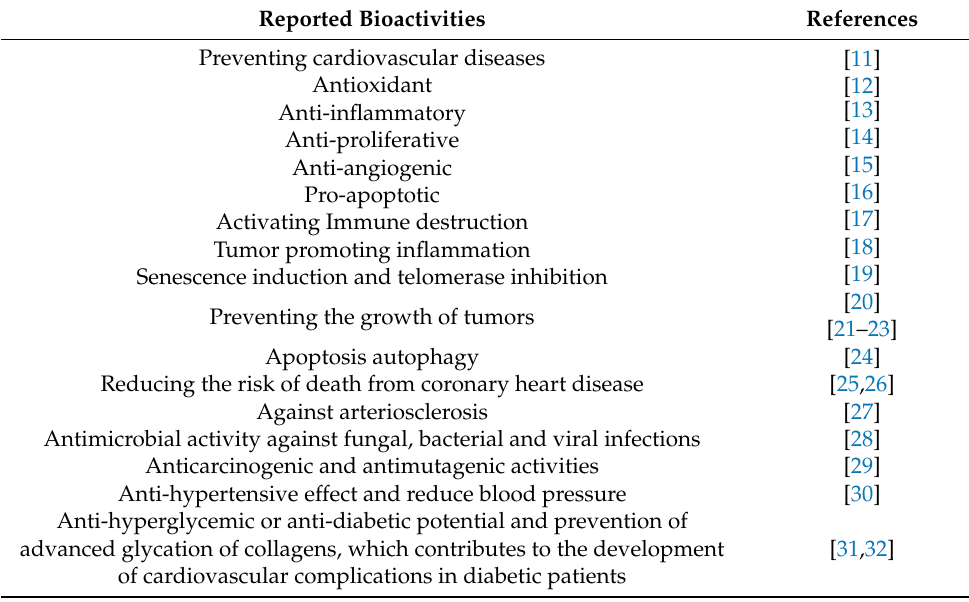
Table 1. Reported bioactivity of phenolics in